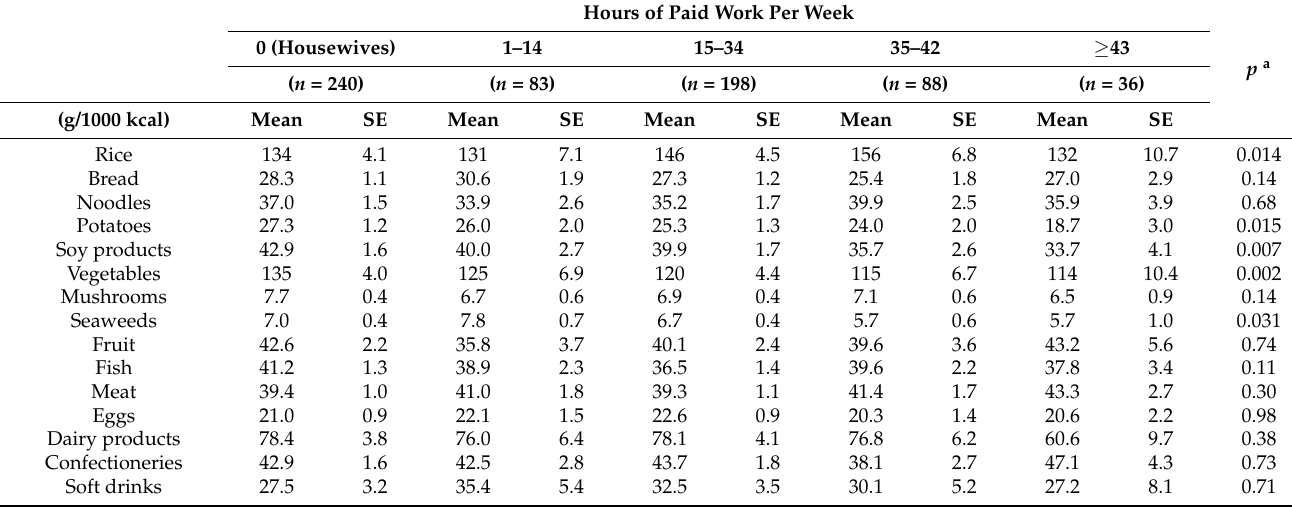
Table 2. Food group intake according to the categories of hours of paid work in 644 Japanese married women.